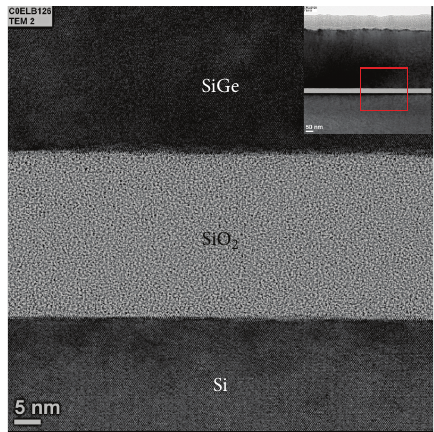
Figure 13: High resolution cross section TEM image of RMG SiGe in the central strip of a tree-like structure.